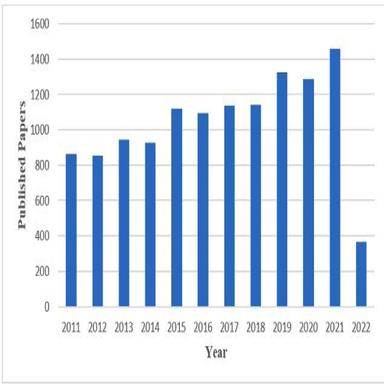
Total publications related to ionic liquid in different studies.